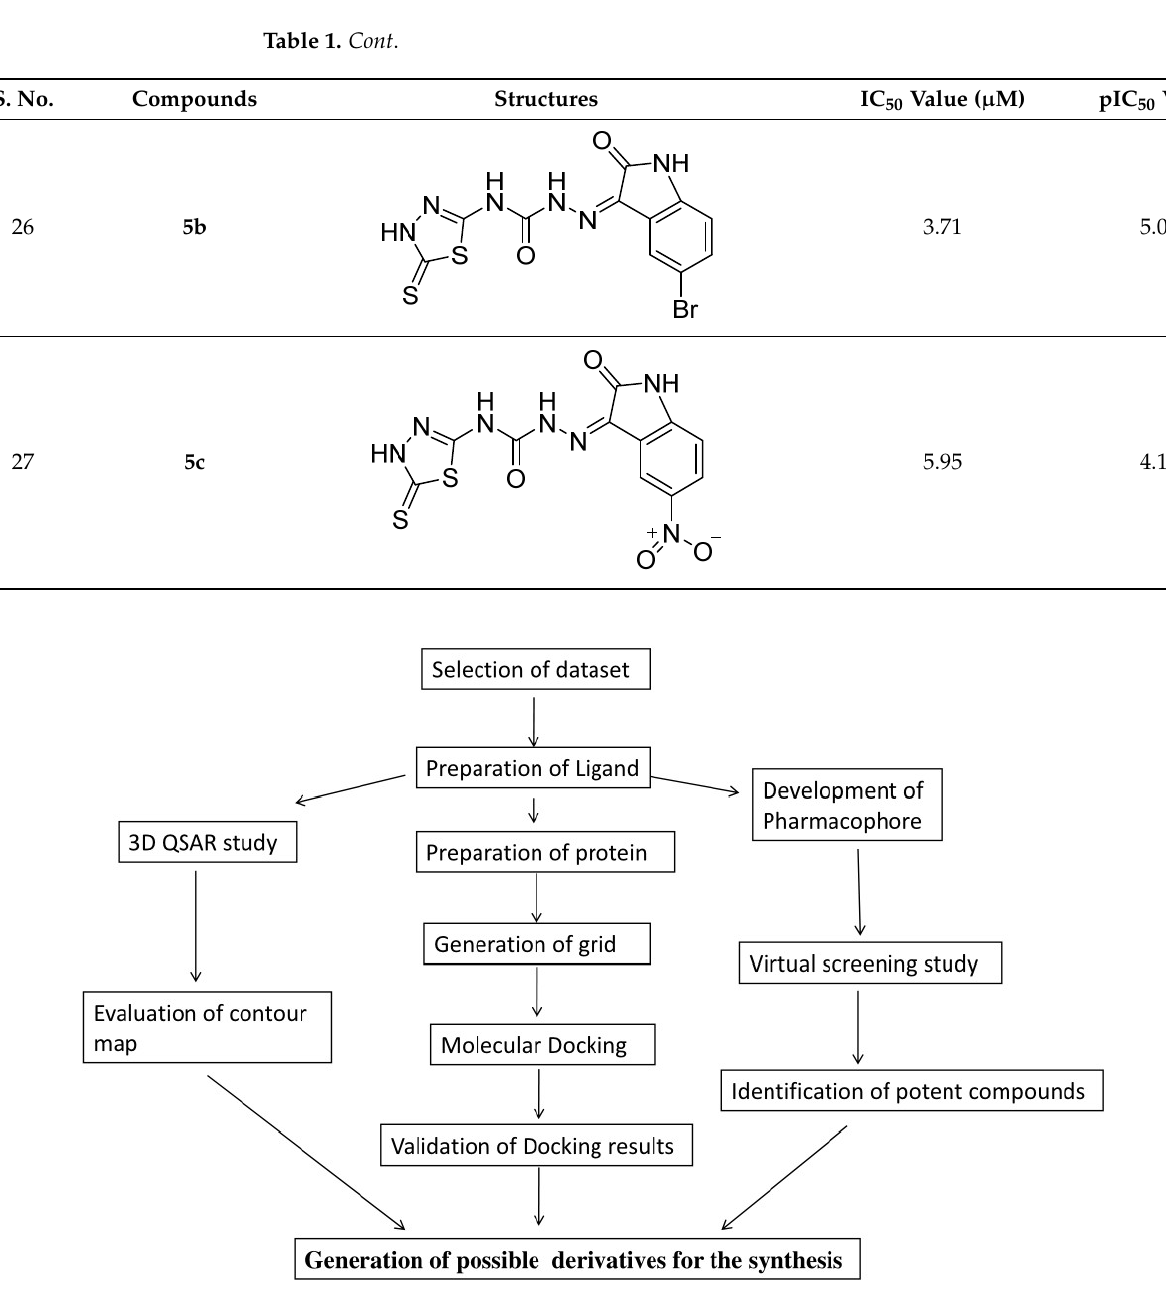
Figure 1. The schematic workflow of 3D QSAR, pharmacophore model, docking, and virtual screen- ing performed in the present study. Table 1. Compounds taken in QSAR study with CA inhibitory activity (IC 50 and pIC 50 value) [21].